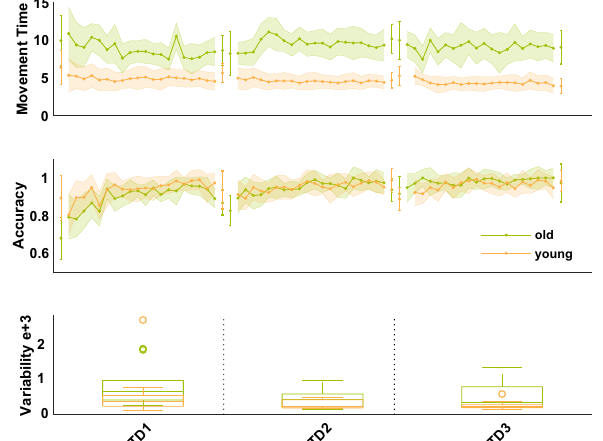
Figure 2. Line Graph shows median values ± 95% Confidence Interval. Green line represents OA, orange line represents